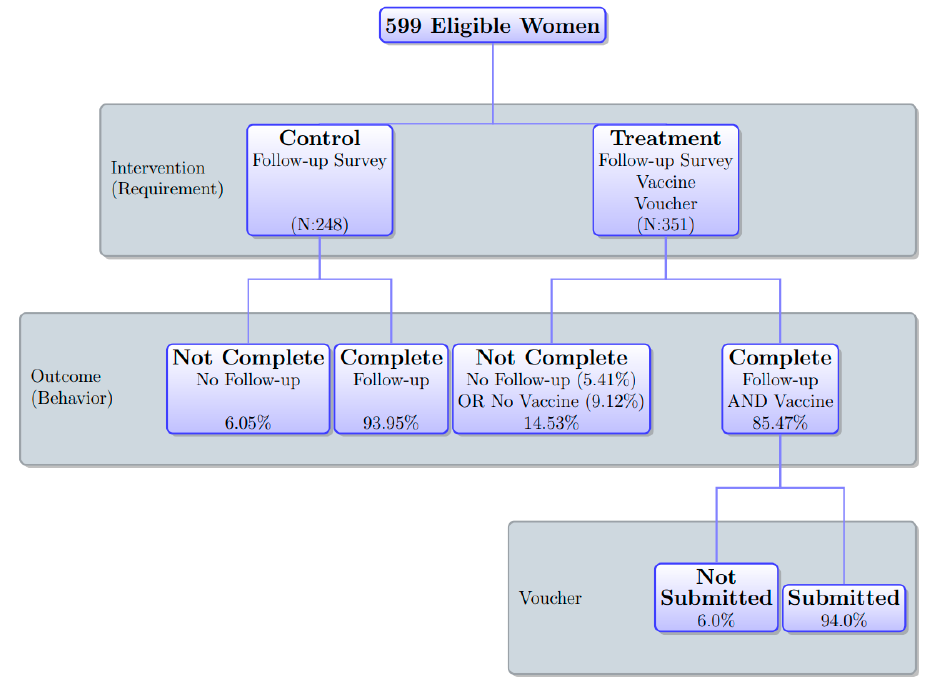
Figure 3. Research design and outcome. Notes: N is the number of observations. The percentage in the “Outcome” shows the percentage of women who fell into each category under each intervention arm (control or treatment), and the percentage in the “Voucher” shows the percentage of women who fell into each category among those who completed the requirement under the treatment arm.